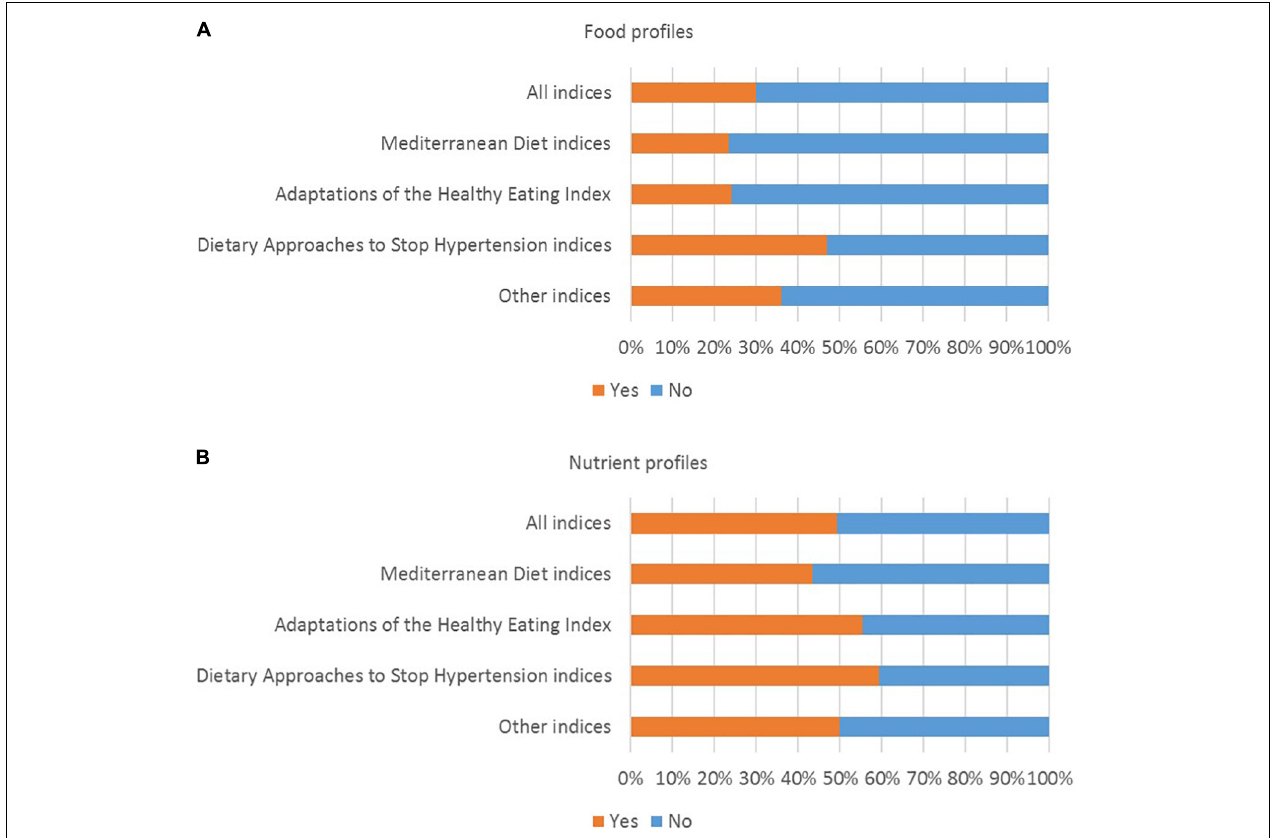
FIGURE 3 | Percentage of indices for which (A) food profiles and (B) nutrient profiles were reported ( n = 463 indices).